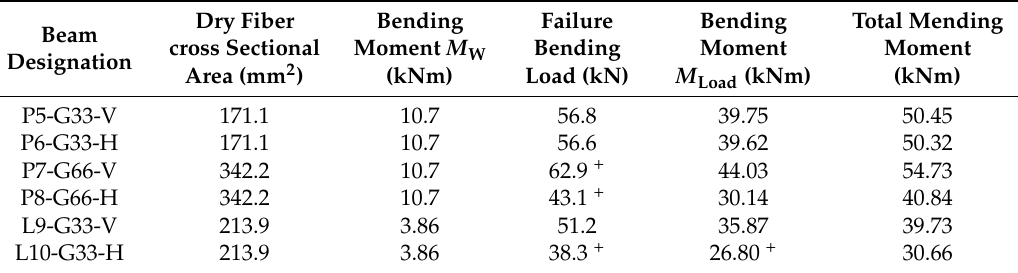
Table 3. Test results on ring